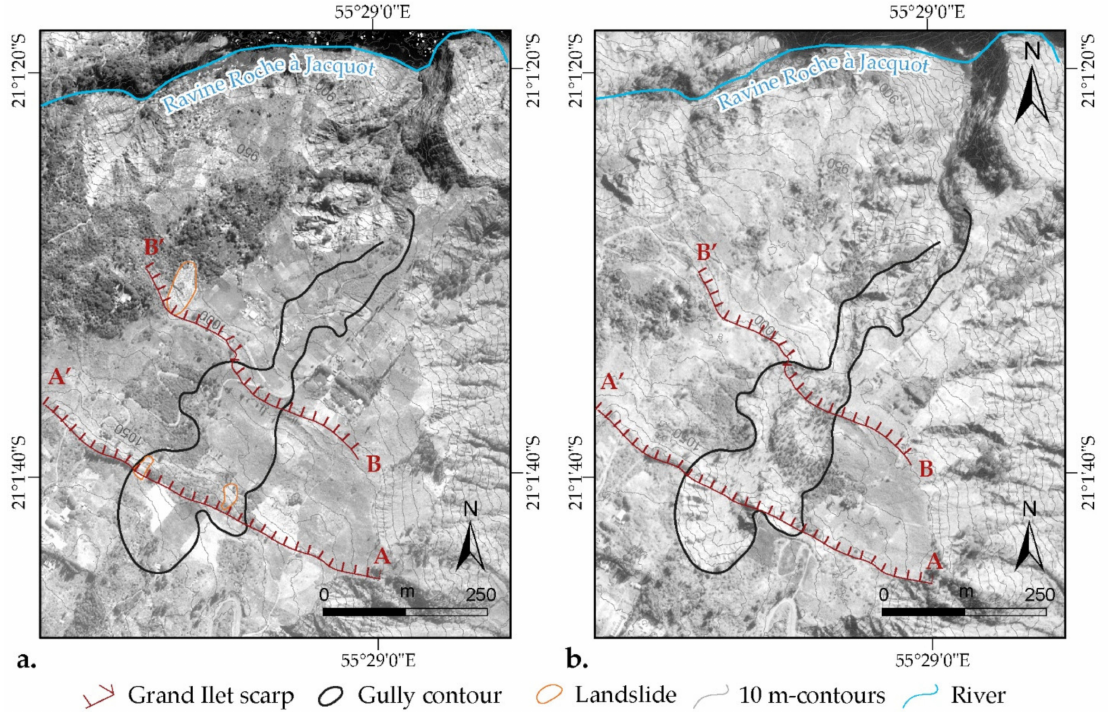
Figure 4. Morphological change following Cyclone Hyacinthe. ( a ). Orthophotograph and elevation lines of 1978. ( b ). Orthophotograph and elevation lines of 1984. The red lines A-A’ and B-B’ are the Grand Ilet scarps imaged in Figure 1. The orange polygons delineate small landslides identified on the aerial images of